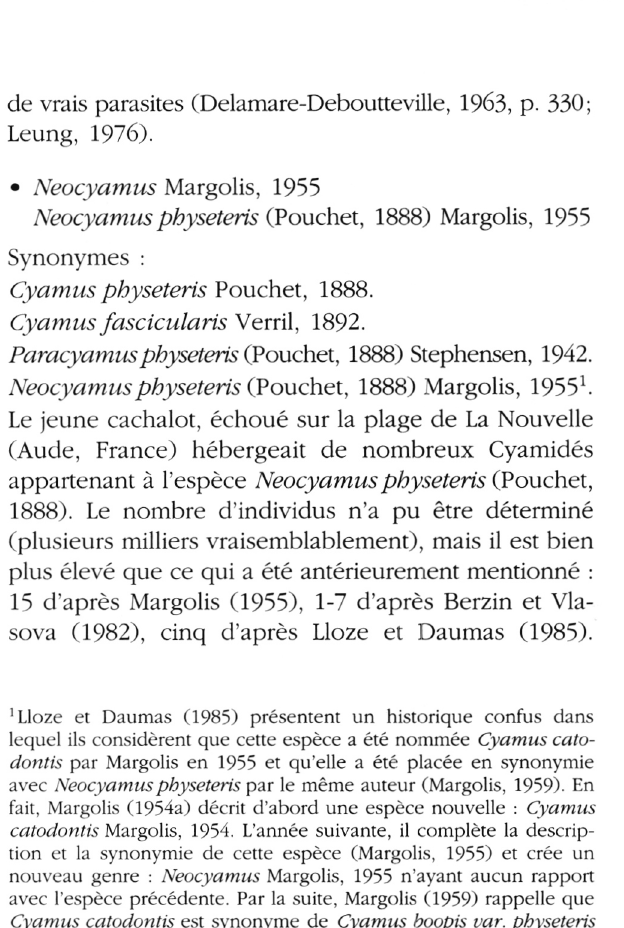
Fig. 1. - Conchoderma vir­ gatum (Spengler, 1790) fixé sur une femelle gestante de Neo­ cyamus physeteris (Pouchet, 1888) parasite du Cachalot, Physeter catodon (Linnaeus, 1758) (échelles : 5